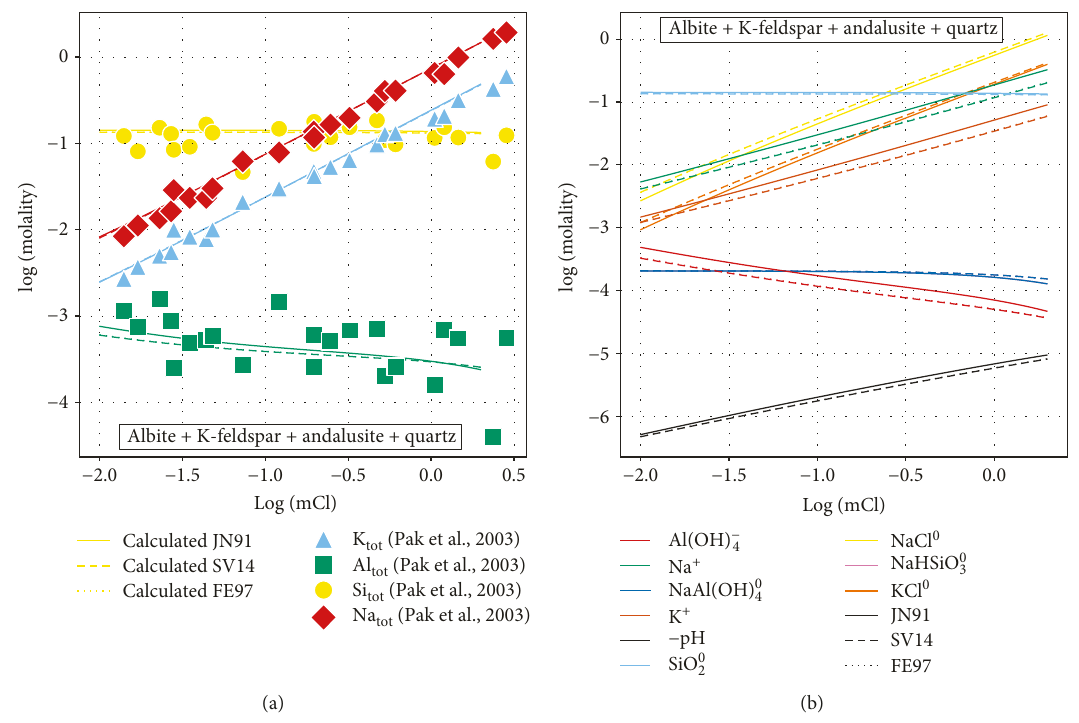
Figure 9: Calculated composition of an aqueous solution in equilibrium with albite, K-feldspar, andalusite, and quartz at 650 ° C, 2kbar, with increasing Cl concentration, using the JN91, SV14, and FE97 models for water dielectric properties and IAPWS95 for water volumetric properties. (a) Total amounts of Na, K, Si, and Al compared with experimental data [86]; (b) amounts of various chemical species for each element. Calculations done with SV14 overlap those done with